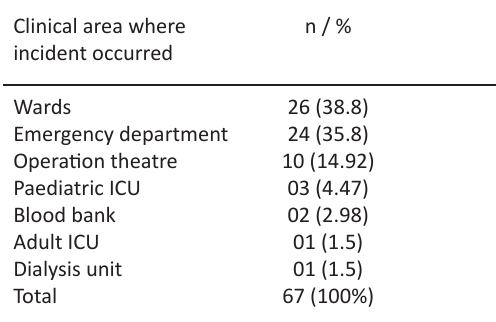
Table 1. Clinical areas Where OBE occurred Clinical area